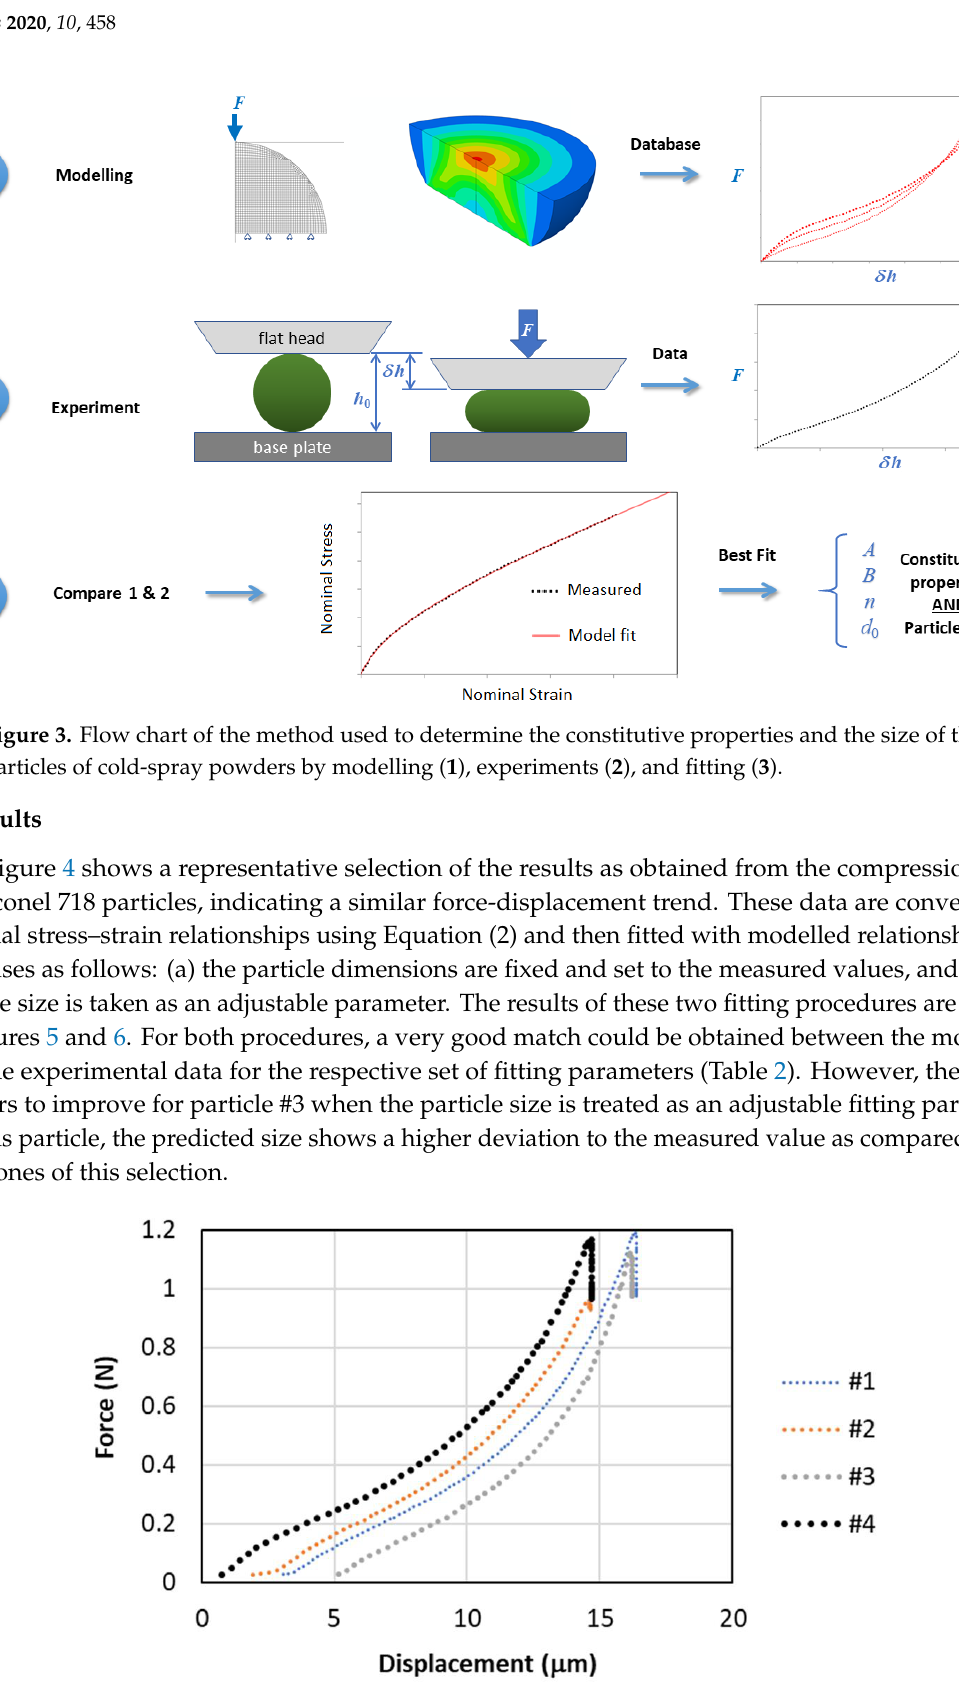
Figure 4. Selected results of raw force-displacement data from compression experiments for Inconel 718 particles of different dimensions (Table 1, particles #1–4) as measured by confocal microscopy.